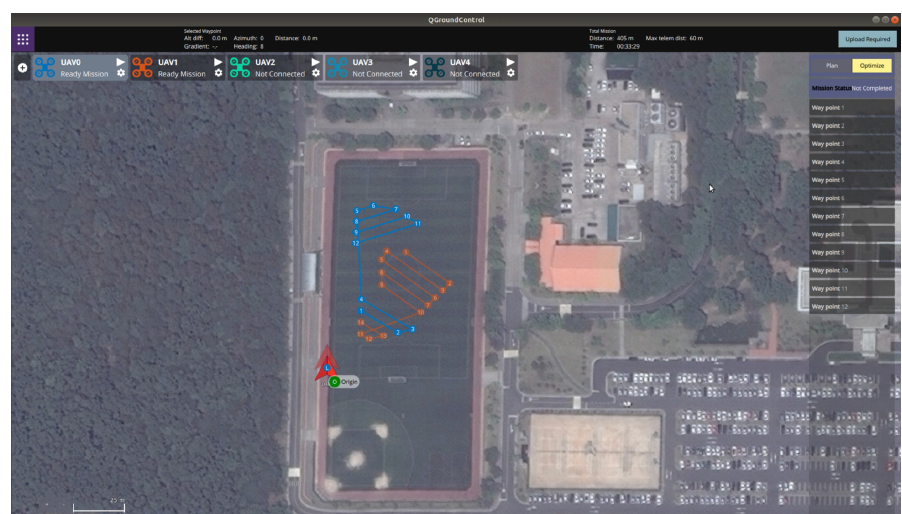
Figure 13. Optimization results shown in QGroundControl.